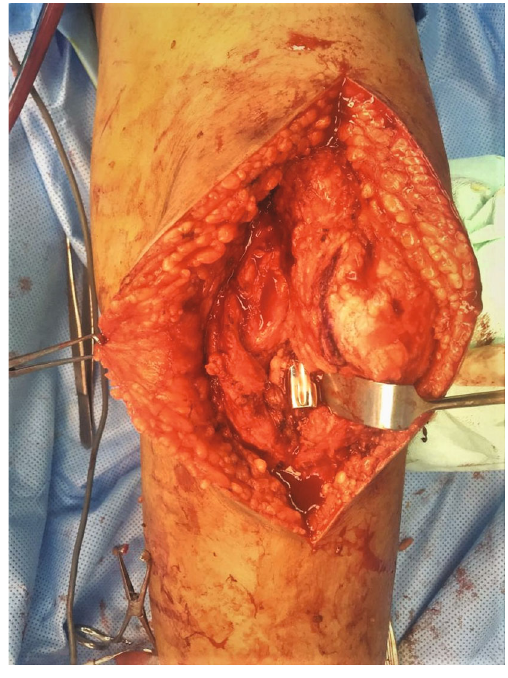
Figure 3: The protruded nail through medial femoral condyle, after debridement.